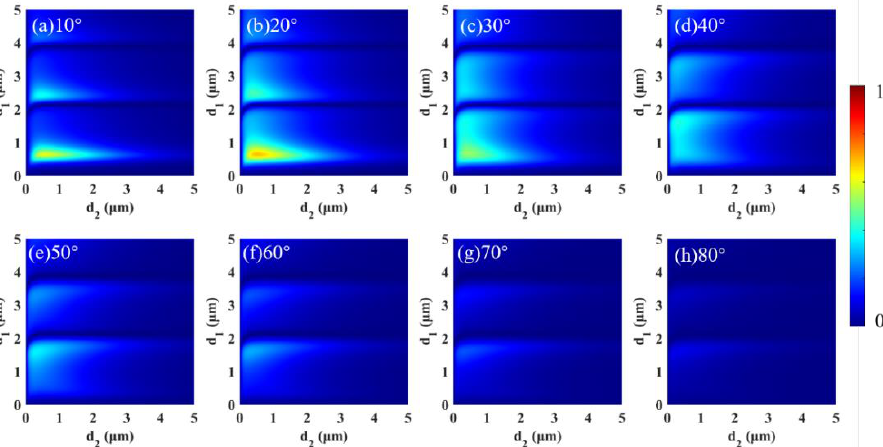
Figure 3. When the wavelength was fixed at 12 μm and f = 0.1, CD varied with d 1 and d 2 for different rotation angles: ( a ) 10°, ( b ) 20°, ( c ) 30°, ( d ) 40°, ( e ) 50°, ( f ) 60°, ( g ) 70° and ( h ) 80°.